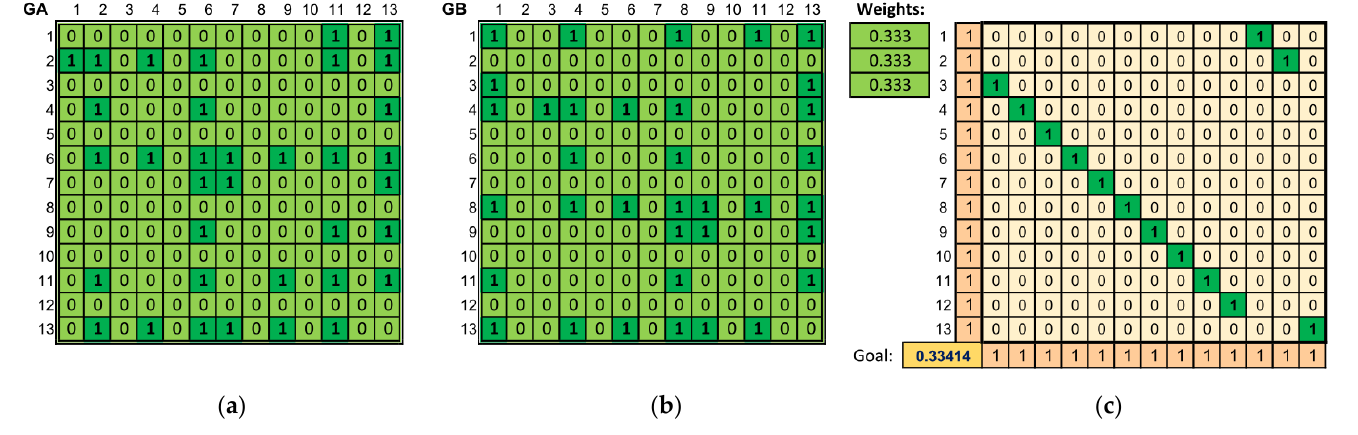
Figure 5. Comparison of Rolling in the Deep in the original and transposed versions. ( a ) The adjacency matrix of the graph representing the original piece. ( b ) The adjacency matrix of the graph representing the transposed work. ( c ) The calculated optimal assignment matrix of vertices from one graph to another (maximizing graph similarity) together with the value of the objective